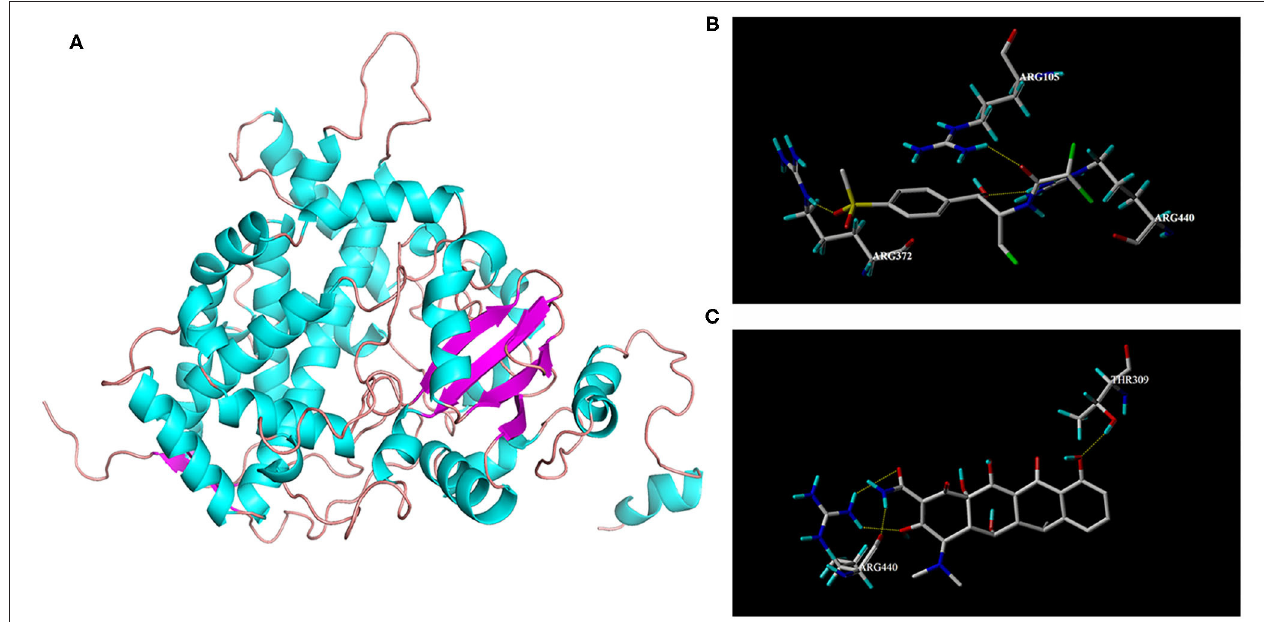
FIGURE 3 | 3D structure of CYP3A24 (A) and interaction with FF (B) and DOX (C) , respectively. (A) 3D structure of CYP3A24 was represented as a cartoon, with α -helices colored in cyan, β -stands in magenta, and loops in salmon. (B) Amino acid residues involved in the interaction of CYP3A24 with FF. (C) Amino acid residues involved in the interaction of CYP3A24 with DOX. The hydrogen bonds were represented as yellow dotted lines. The FF molecular was colored in gray.